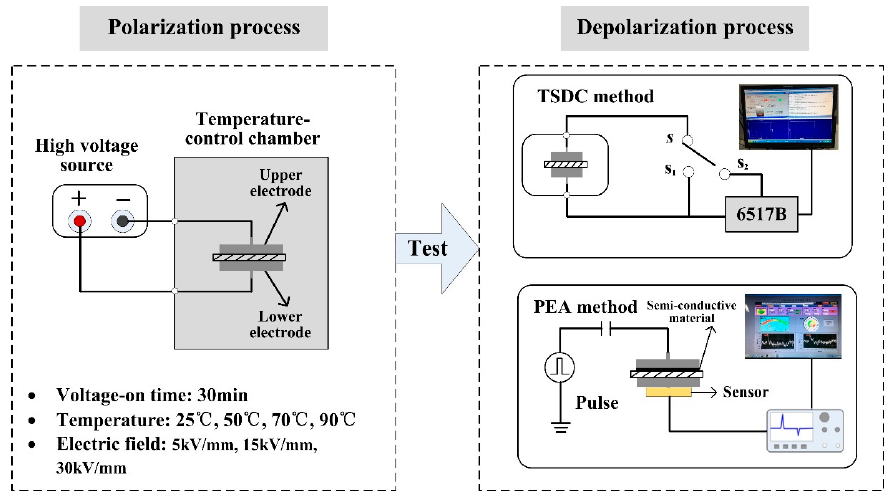
Figure 1. Schematic diagram of experimental setup and conditions: ( a ) Polarization process performed within a temperature controlled device; ( b ) depolarization process implemented by TSDC method and PEA method.